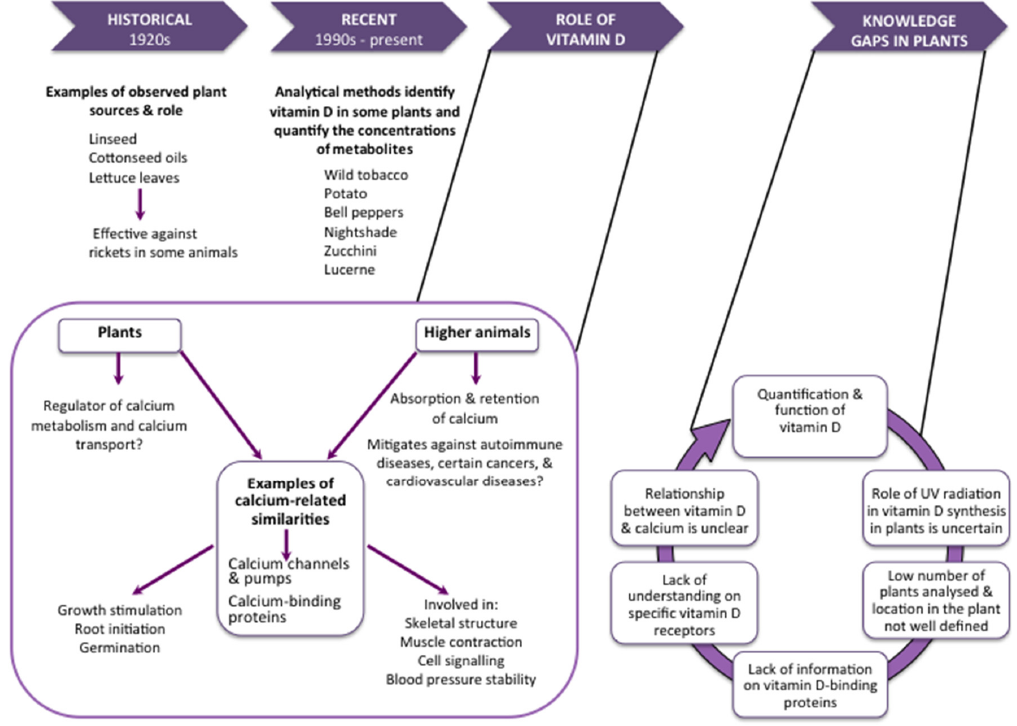
Figure 1. Vitamin D in plants: current knowledge and research gaps.